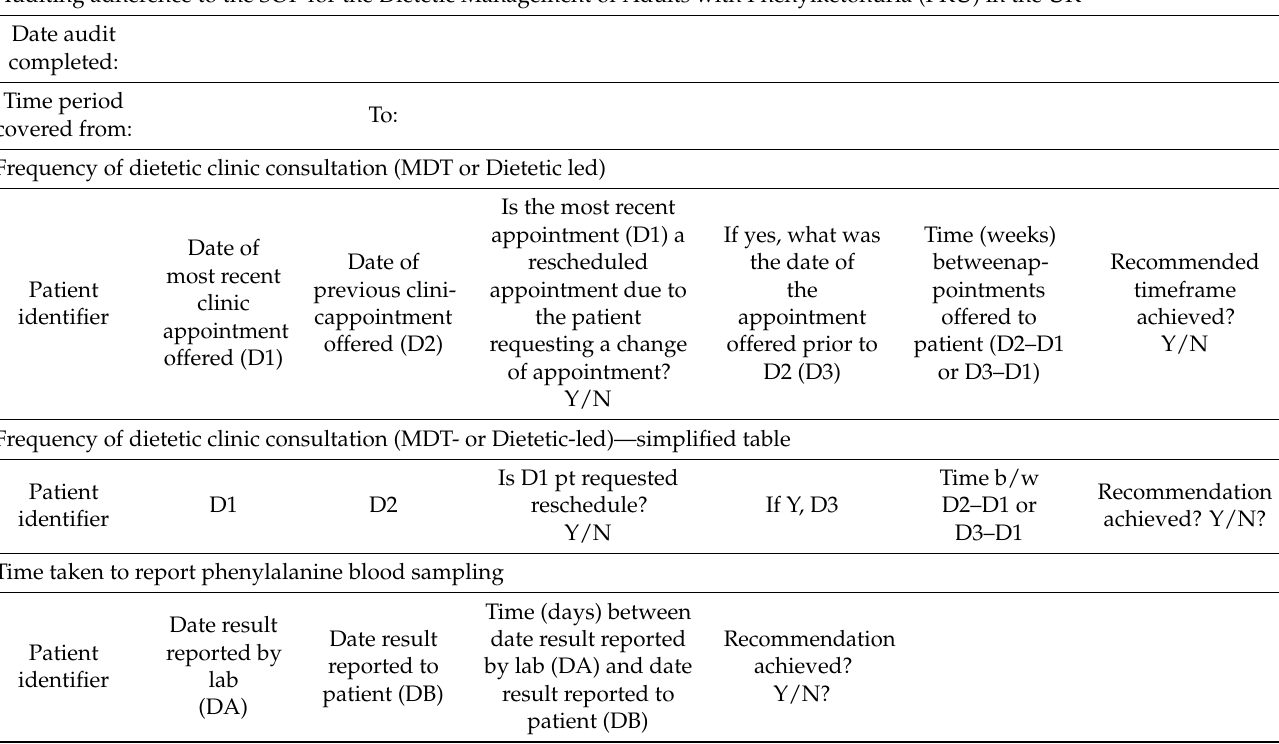
Table A1. Suggested Audit tool for the